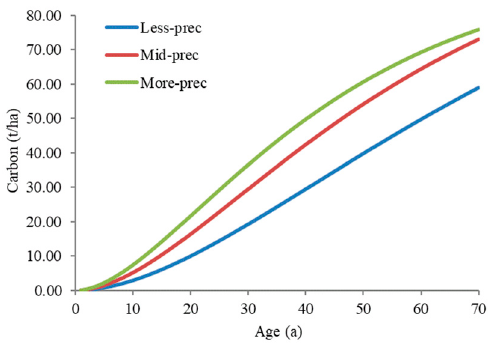
Figure 10. Growing process of carbon storage in P. tabuliformis plantation under three climate sce-